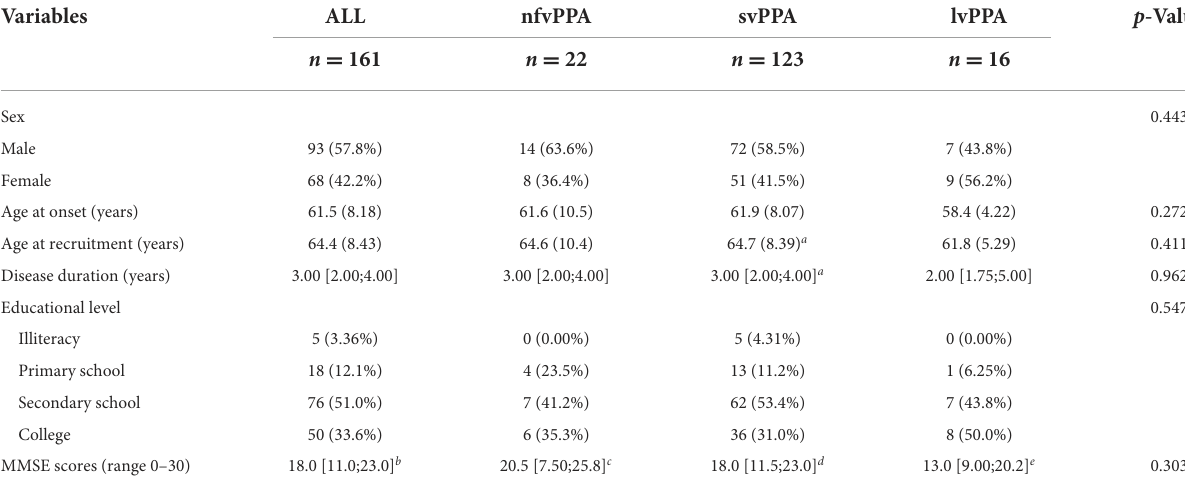
TABLE 1 Demographic characteristics and clinical scores in patients with PPA variants.